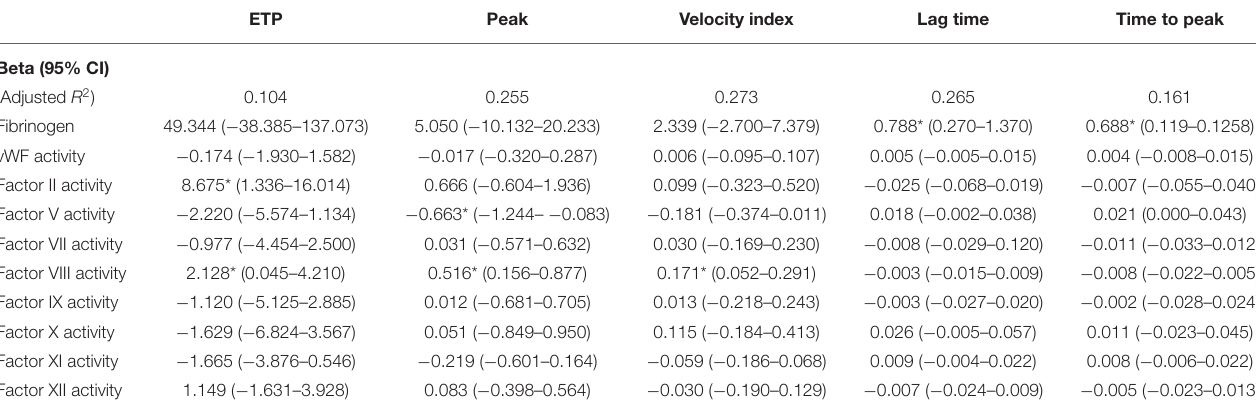
TABLE 3 | Coagulation factors as determinants of thrombin generation—multiple regression